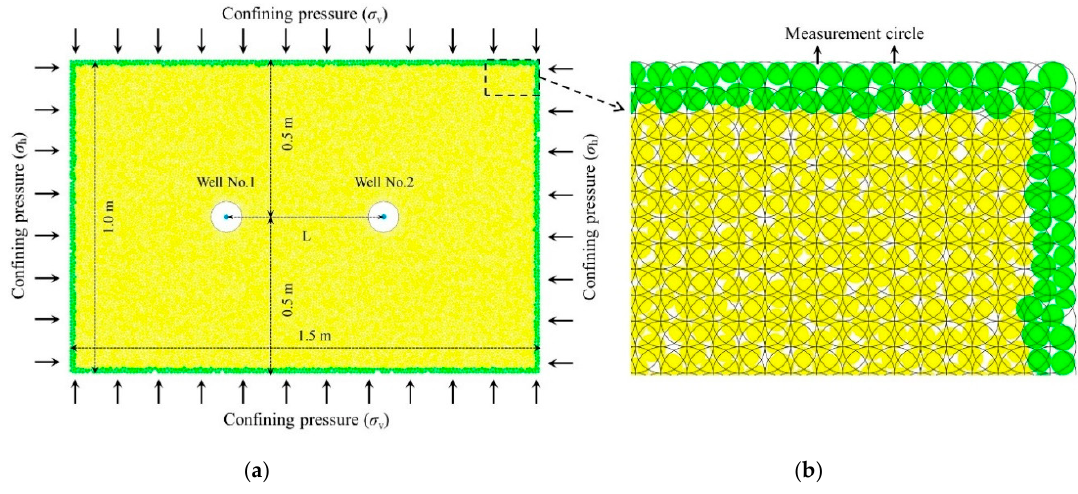
Figure 8. Granite model with two injection wells for hydraulic fracturing: ( a ) the model size and applied boundary conditions; and ( b ) arrangement of measurement circles.